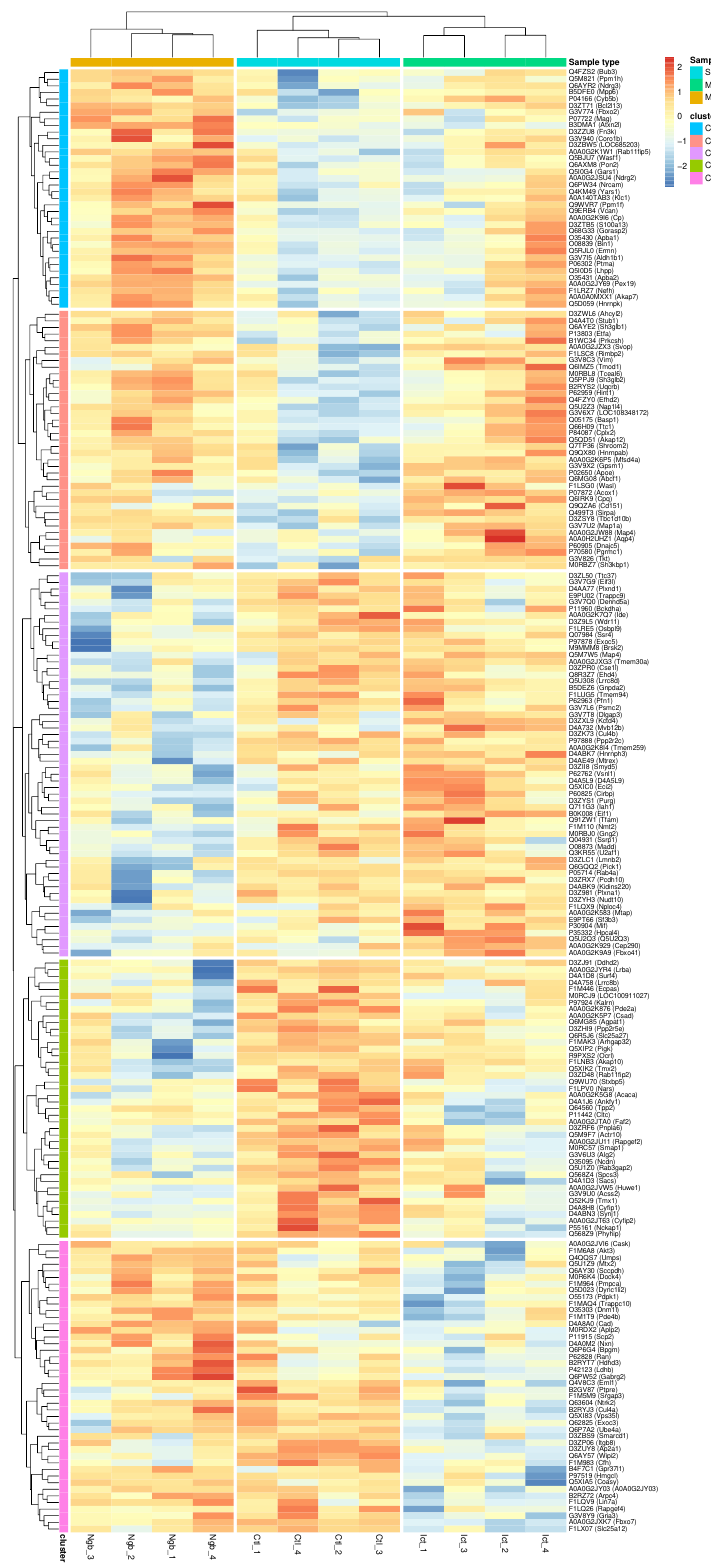
Figure 12. Hierarchical clustering using the intensities of proteins that present a p < 0.02 in at least one of the three comparisons (MCAO vs. sham, MCAO-Ngb vs. MCAO, and MCAO-Ngb vs. sham). The five main aggrupation of proteins are highlighted as cluster 1 to cluster 5 at row level. The three types of samples (sham, MCAO, and MCAO-Ngb) are highlighted at column